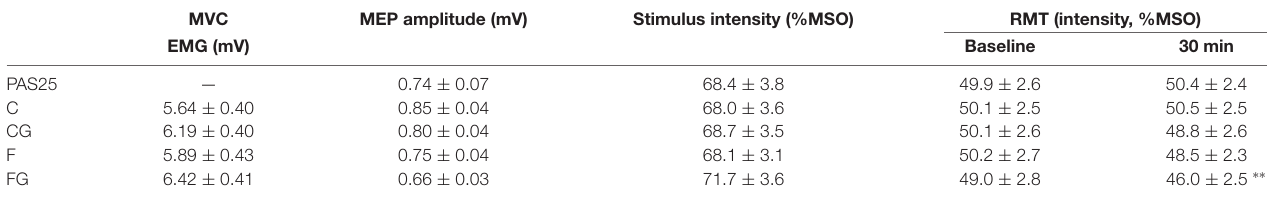
TABLE 1 | Description of baseline values measured before interventions and resting motor threshold (RMT) changes after interventions. MVC MEP amplitude (mV) Stimulus intensity (%MSO) RMT (intensity, %MSO) EMG (mV) Baseline 30 min PAS25